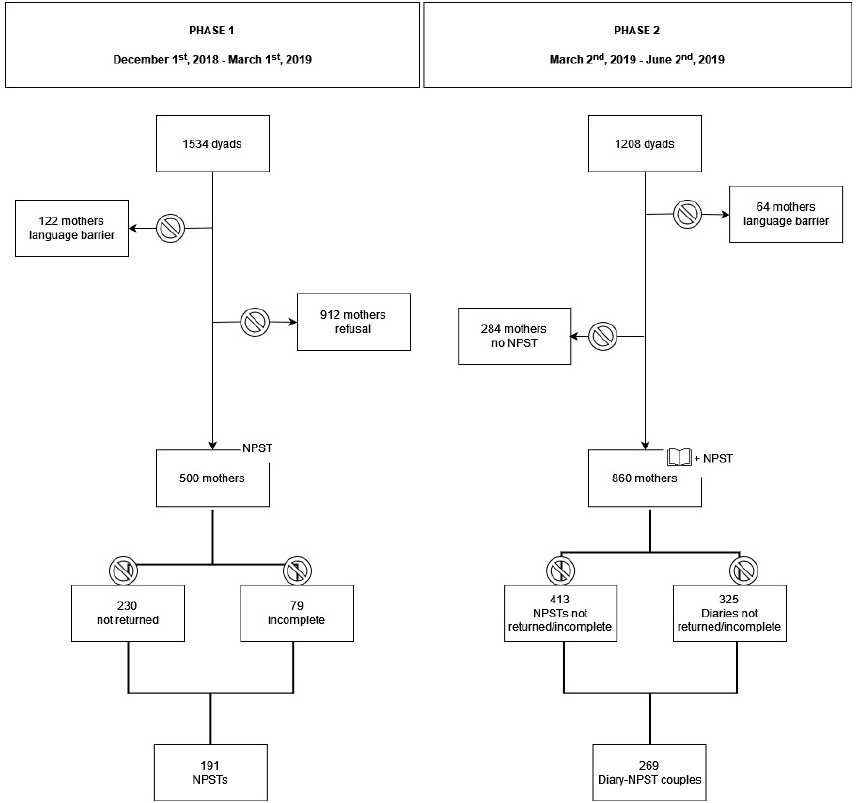
Figure 1. Participants’ flow through